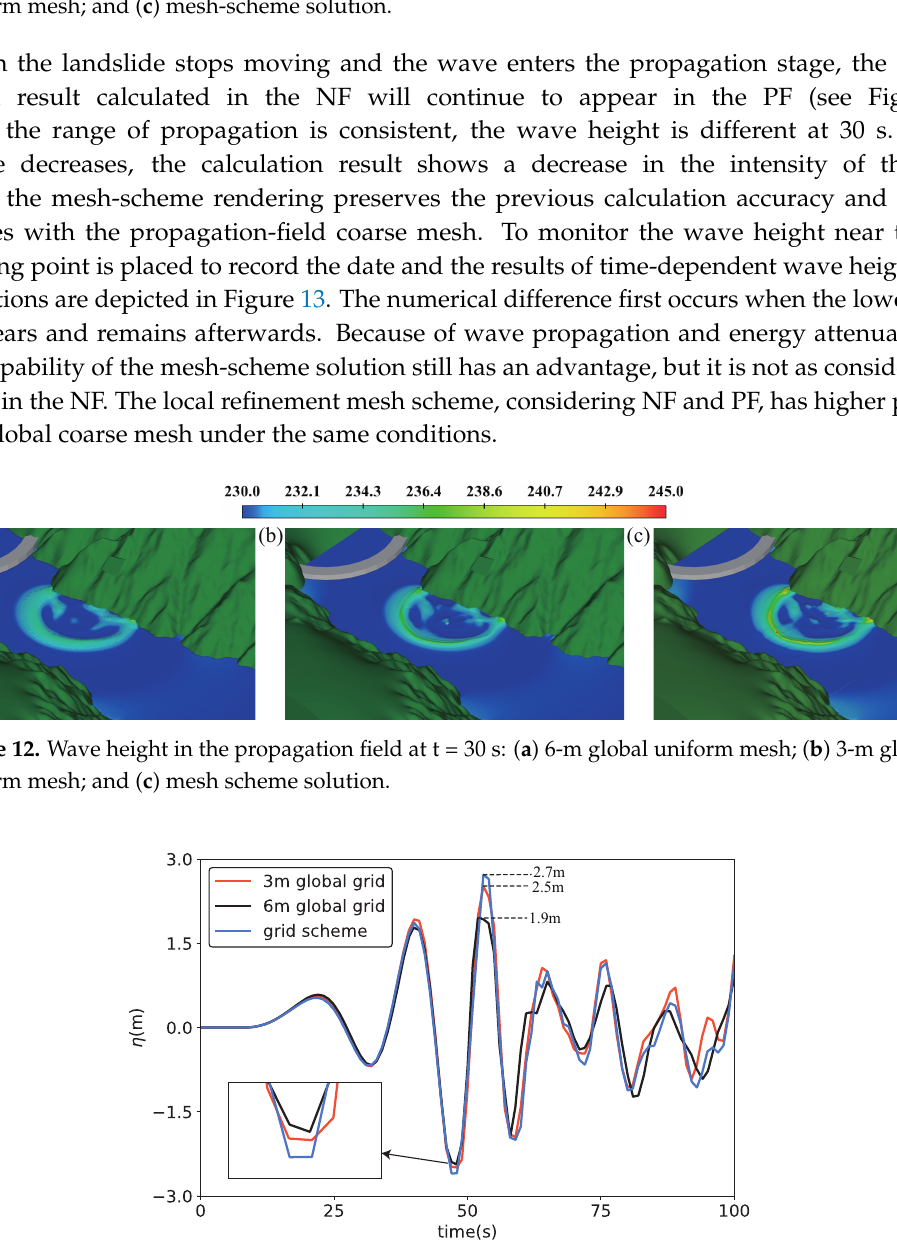
Figure 13. Wave height near the